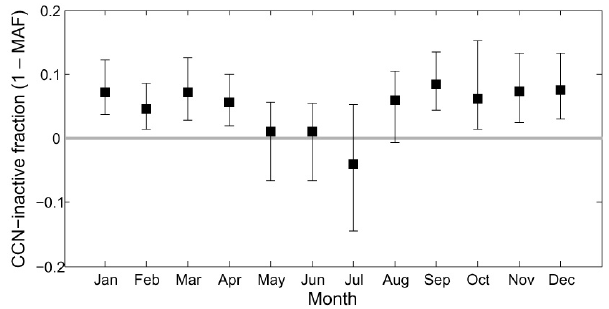
Fig. 11. Monthly median CCN-inactive fraction (1 – MAF), calcu- lated from the non-normalised fitting of Eq. (2) to each activation spectrum. Error bars are 25th and 75th